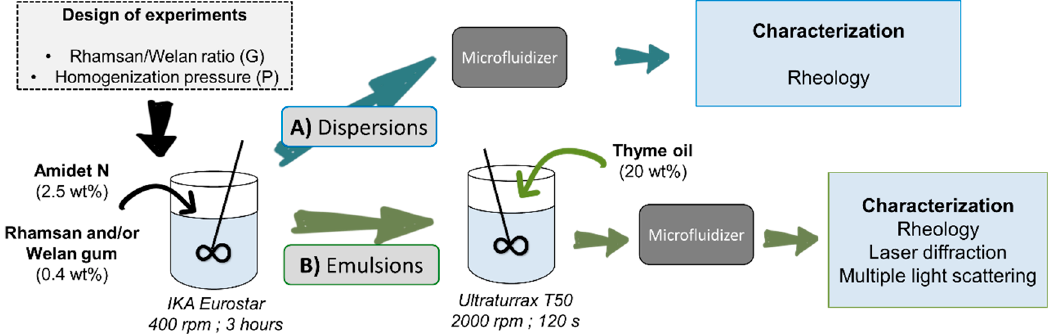
Figure 1. Scheme of the continuous phases and emulsion development.